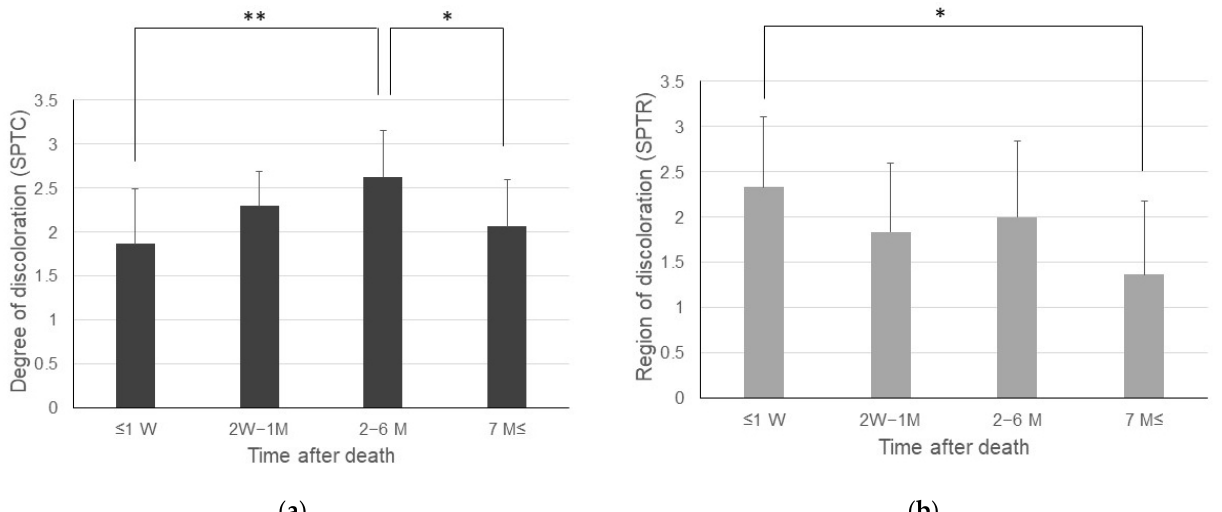
Figure 4. Associations of SPTC ( a ) and SPTR ( b ) with time after death (68 cases, n = 11–36). ( a ) SPTC for 2–6 months showed a significant increase compared with ≤ 1 week ( p < 0.01) and after 7 months showed a significant decrease compared with 2–6 months ( p < 0.05).; ( b ) SPTR after 7 months showed a significant decrease compared with ≤ 1 week ( p < 0.05). ** p < 0.01, * p < 0.05. SPTC, Score of Pink Teeth Color; SPTR, Score of Pink Teeth Region.